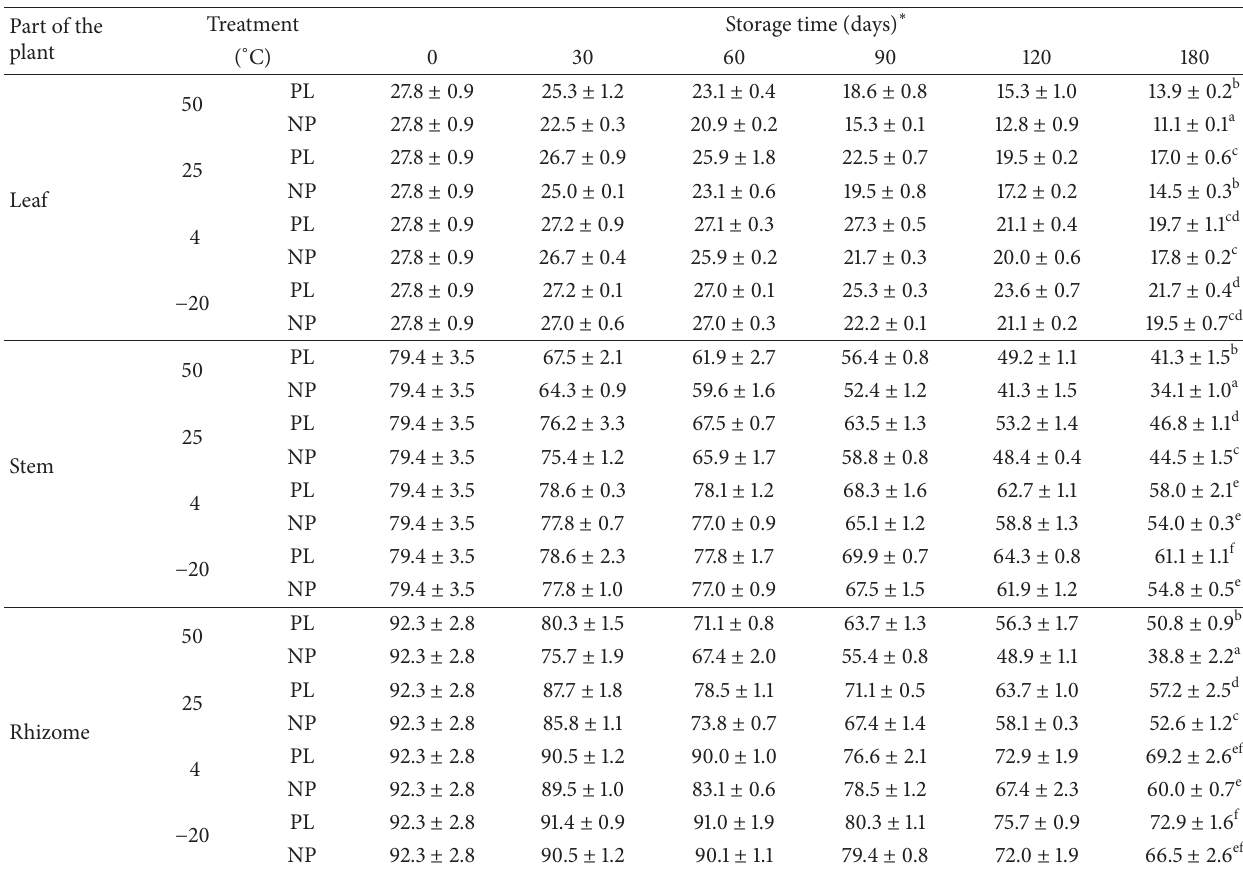
Table 1: Methanolic extract yields of leaf, stem, and rhizome from Anemopsis californica . Sample